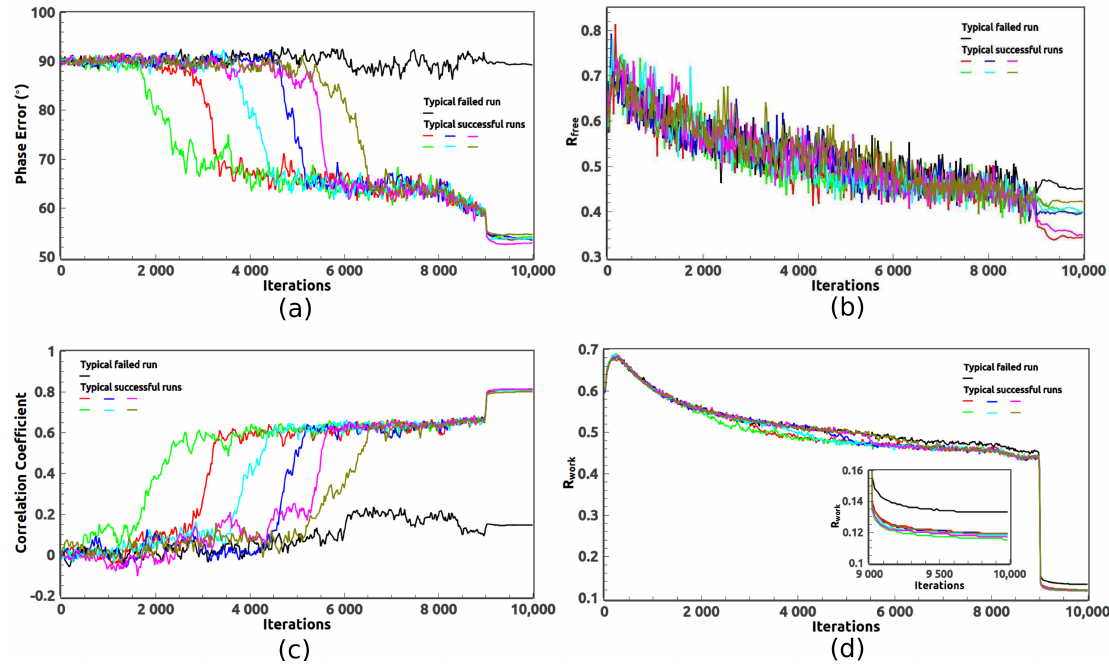
Figure 1. The evolution of ( a ) ∆ φ , ( b ) R free , ( c ) CC , and ( d ) R work for the ab initio phasing of 2JLN using 2.85 Å observed data. For clarity, one typical failed run and six successful runs are